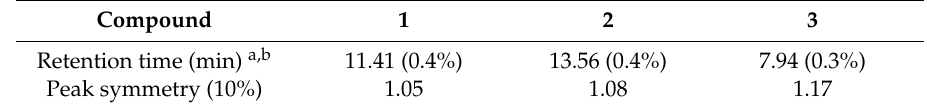
Table 1. Parameters of the system suitability of the UHPLC methodology.